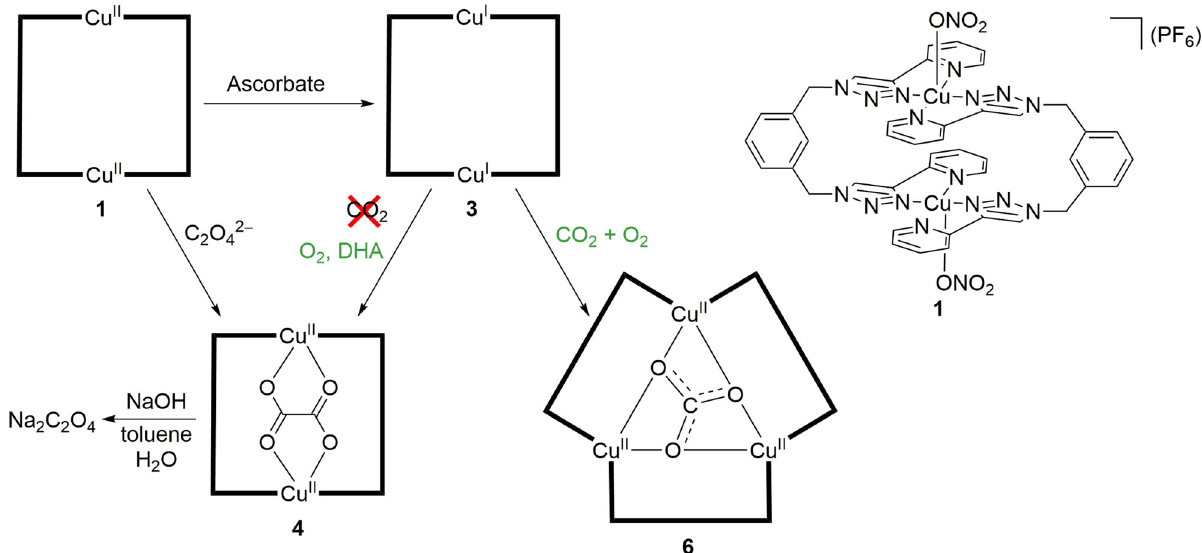
Fig. 1 Reactions of Cu(II) complex 1 and the Cu(I) complex 3 obtained by reduction of 1 with ascorbate. For the formation of oxalate complex 4 from 3 , CO 2 was previously reported to be required. We show here that the reaction requires ascorbate or dehydroascorbic acid (DHA), and oxygen. If ascorbate and DHA are absent, oxidation of 3 in air produces 6 . All reactions were conducted in DMF, except for the removal of oxalate from 4 (Note: 1 , 3 , and 4 represent the same compounds as in ref. 16 ).